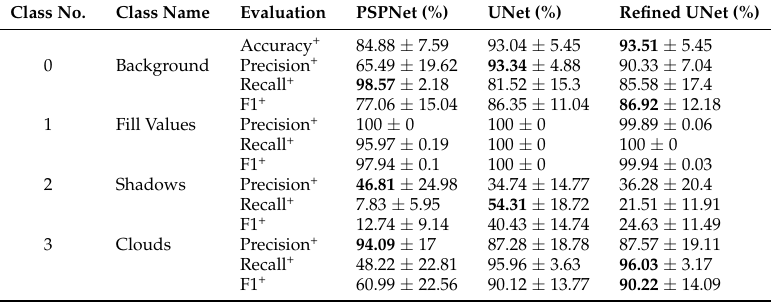
Table 1. Average scores of accuracy, precision, recall, and F1 of PSPNet, the backbone (UNet), and Refined UNet. The top results are highlighted in